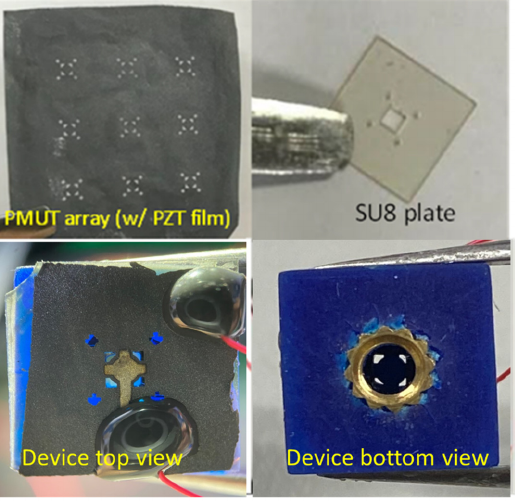
Figure 4. Photographs of the fabricated components and complete device.